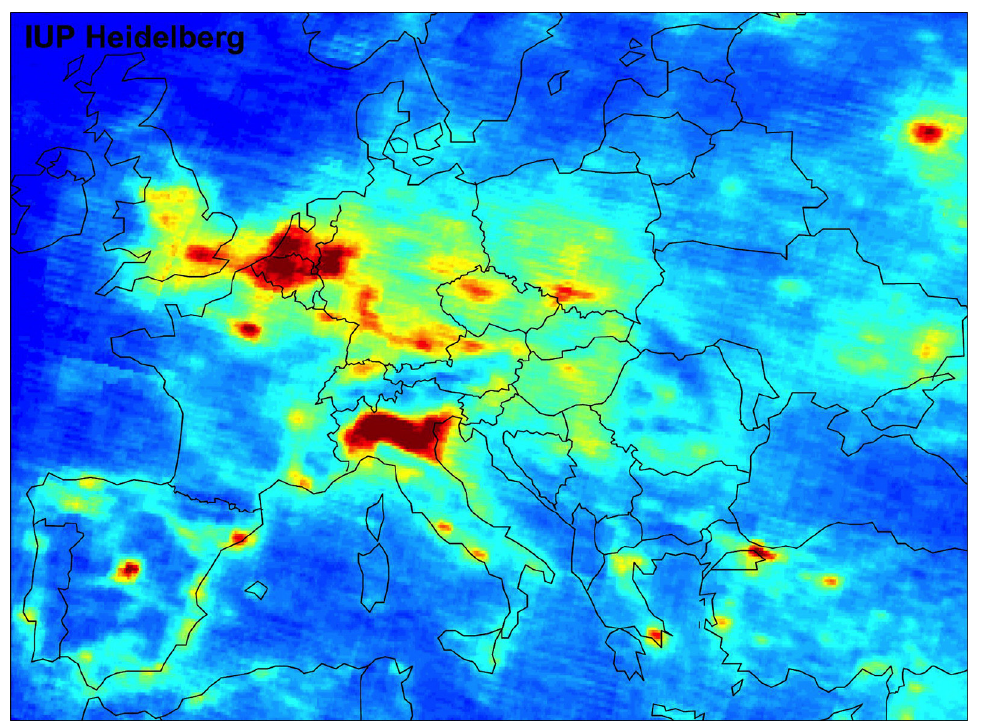
Fig. 8. – European mean tropospheric nitrogen dioxide (NO 2 ) vertical column density (VCD) between January 2003 and June 2004, as measured by the SCIAMACHY instrument on ESA’s Envisat. Image produced by S. Beirle, U. Platt and T. Wagner of the University of Heidelberg’s Institute for Environmental Physics. (Courtesy of T.